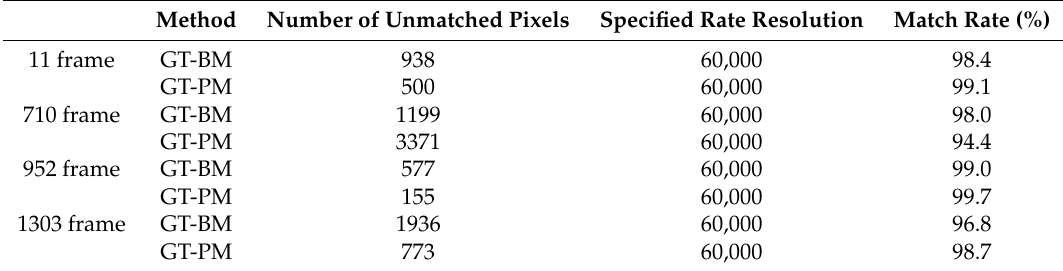
Table 2. Match rate of different images in match-moving with cross